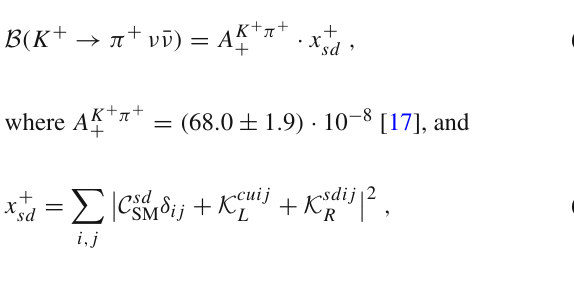
Table 3 Coefficients A h c F ± , as defined in (15), and model-independent upperlimitson B max , B max , B max from(11),(12)and(13),respectively, LU cLFC correspondingtotheleptonflavorsymmetrybenchmarks i) - iii) .Thefirst two columns are taken from Ref. [22]